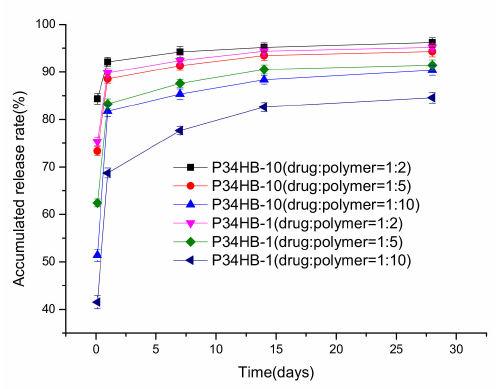
Figure 4. Drug release profiles of coatings with different drug polymer